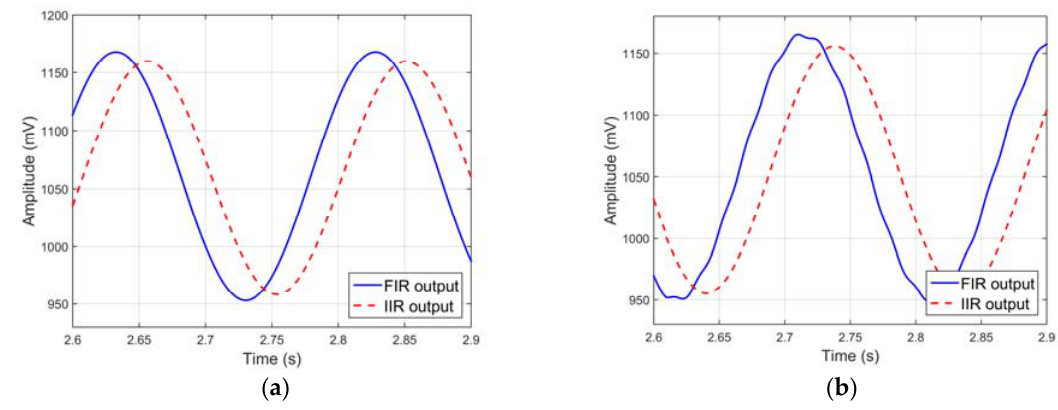
Figure 9. System response to a 100 Hz added noise. ( a ) Filter responses to a 100 mV @100 Hz added sine signal; ( b ) filter responses to a 100 mV @ 100 Hz added square signal.